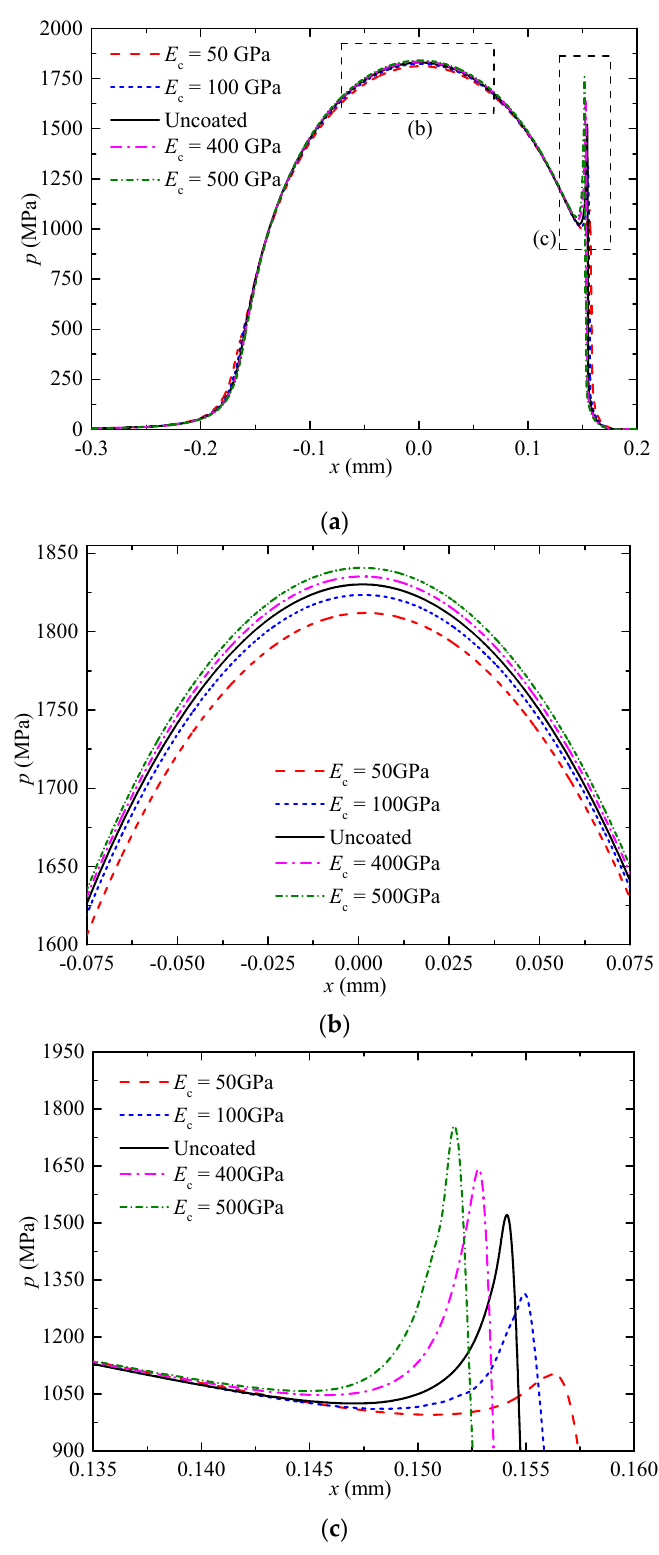
Figure 6. Oil film pressure distribution under different coating elastic moduli: ( a ) overall pressure curves, ( b ) magnification of center pressure, and ( c ) secondary pressure peak.